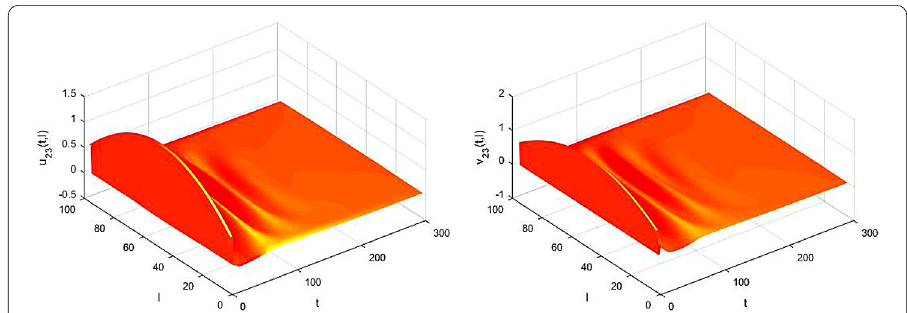
Figure 8 The trajectory of u 23 ( t , l ) and v 23 ( t , l ).